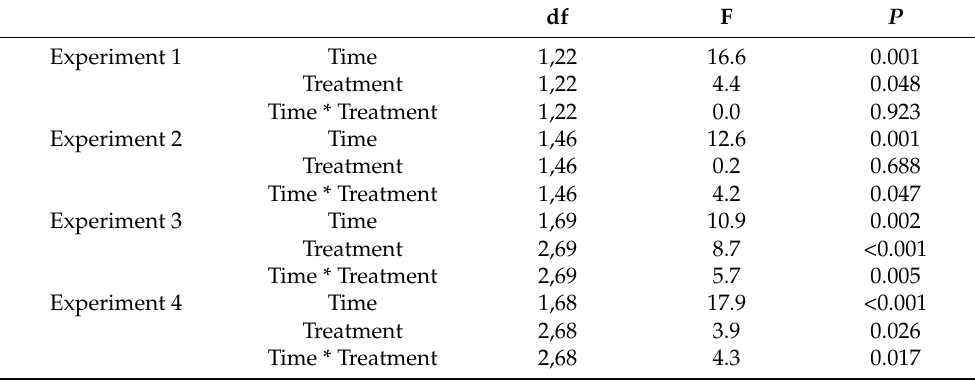
Table 2. Results of repeated measures one-way ANOVA testing for the effects of treatment, moni- toring time and its interaction (Time * Treatment) on the D. magna visual responses across the last minute of darkness and the 5 min of light. Results for four identical experiments are reported.